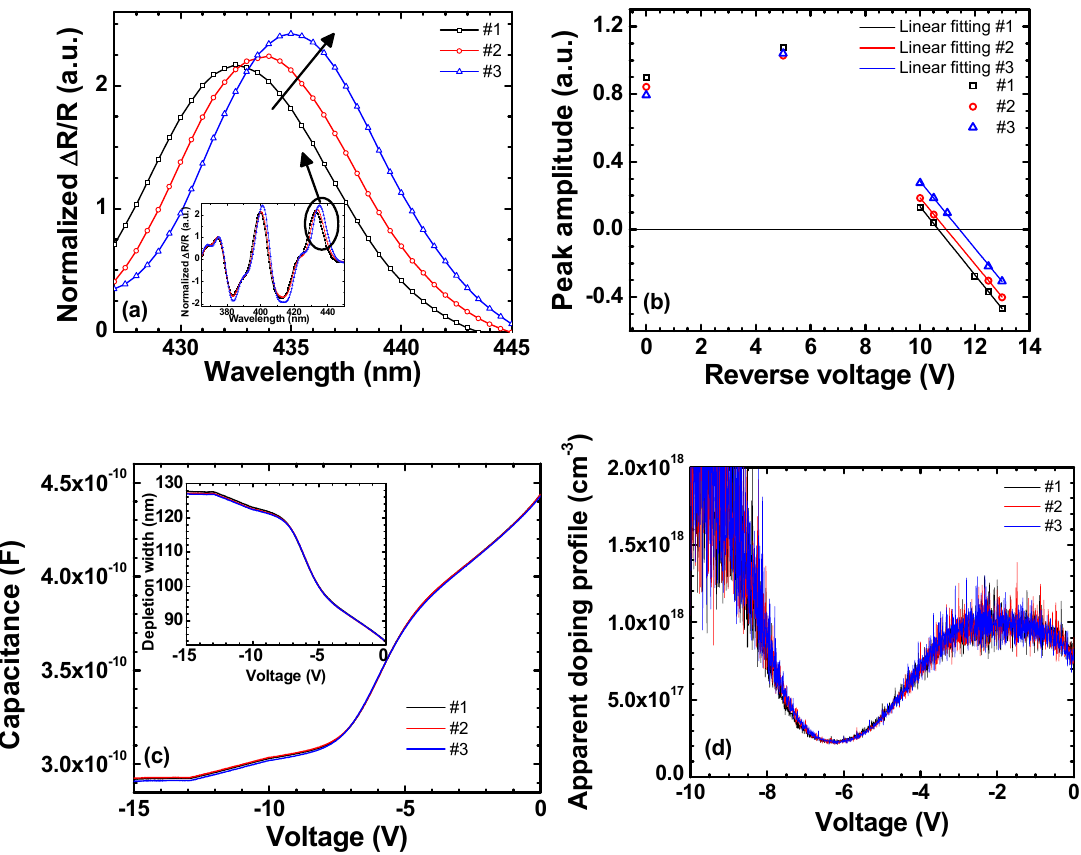
Figure 1. ( a ) Normalized ER spectra measured at a bias of 0 V. The inset shows the ER spectra from 360 to 460 nm. ( b ) The peak amplitude at the MQW region as a function of applied reverse bias. ( c ) The C-V characteristics. The inset shows the calculated depletion width. ( d ) The apparent doping profile obtained from ( c ).